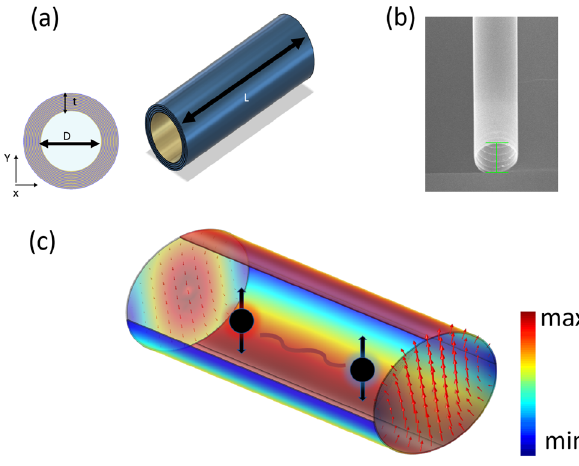
Figure 2: Rolled-up zero-index waveguide schematics and fabricated